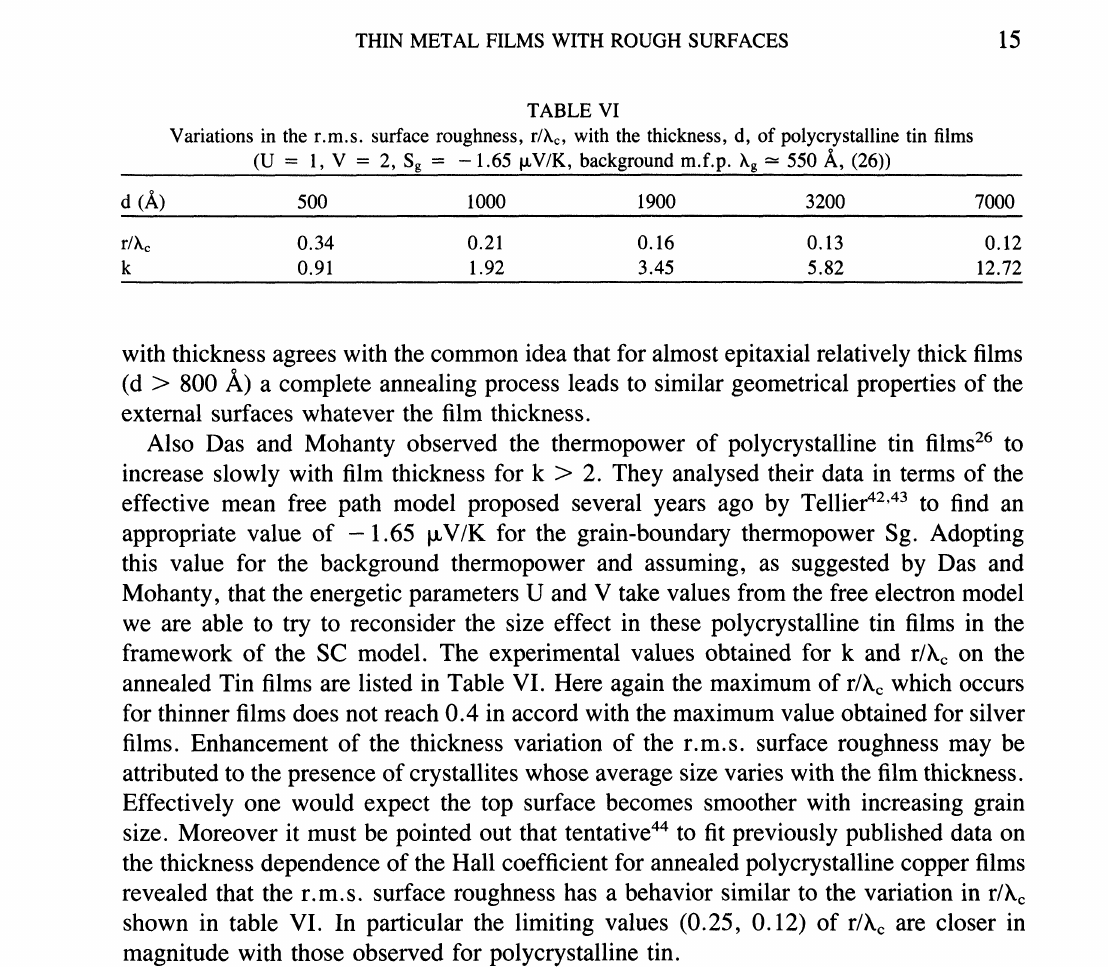
Variations in the r.m.s, surface roughness, r/kc, with the thickness, d, of polycrystalline tin